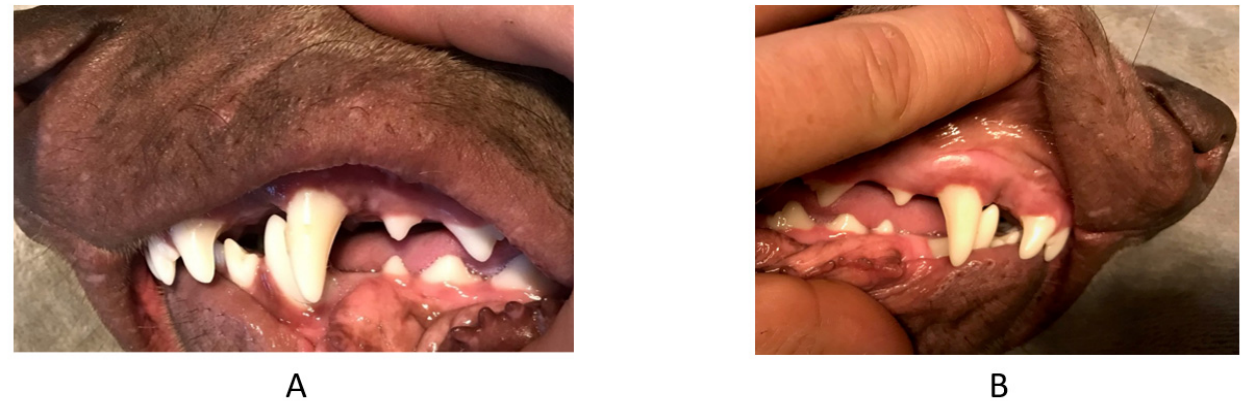
Figure 10. Third case. Intraoral profile photographs 2 months after the start of treatment. ( A ) left side, ( B ) right side.